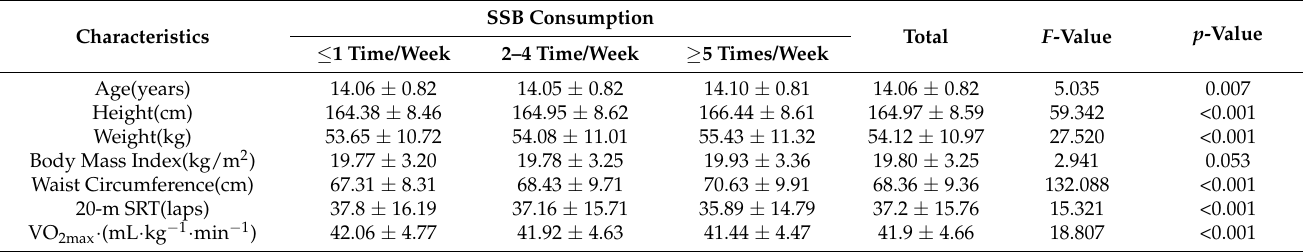
Table 2. One-way analysis of variance on health indicators of children with different SSB consumption in China.